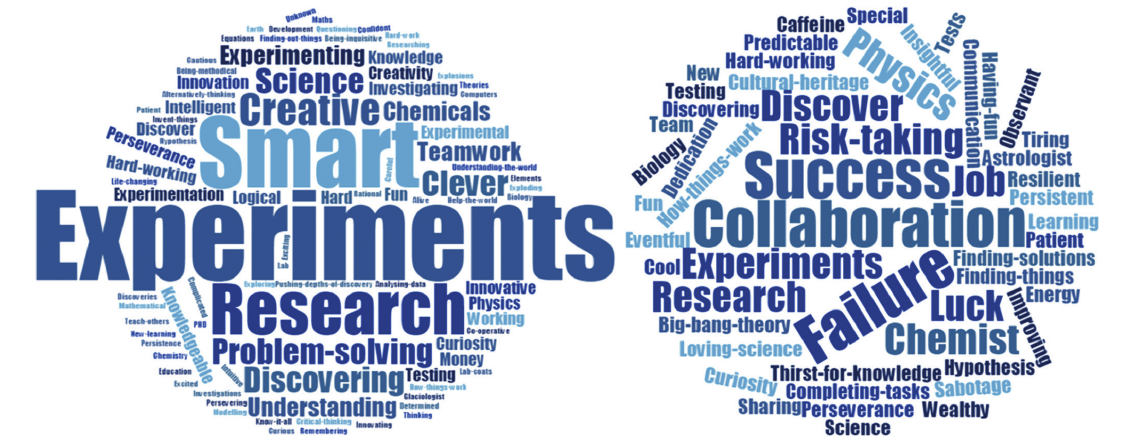
Figure 9. Word clouds from the ‘Being a scientist means’ question before (left) and after (right) playing Diamond: The Game (Source: Authors,